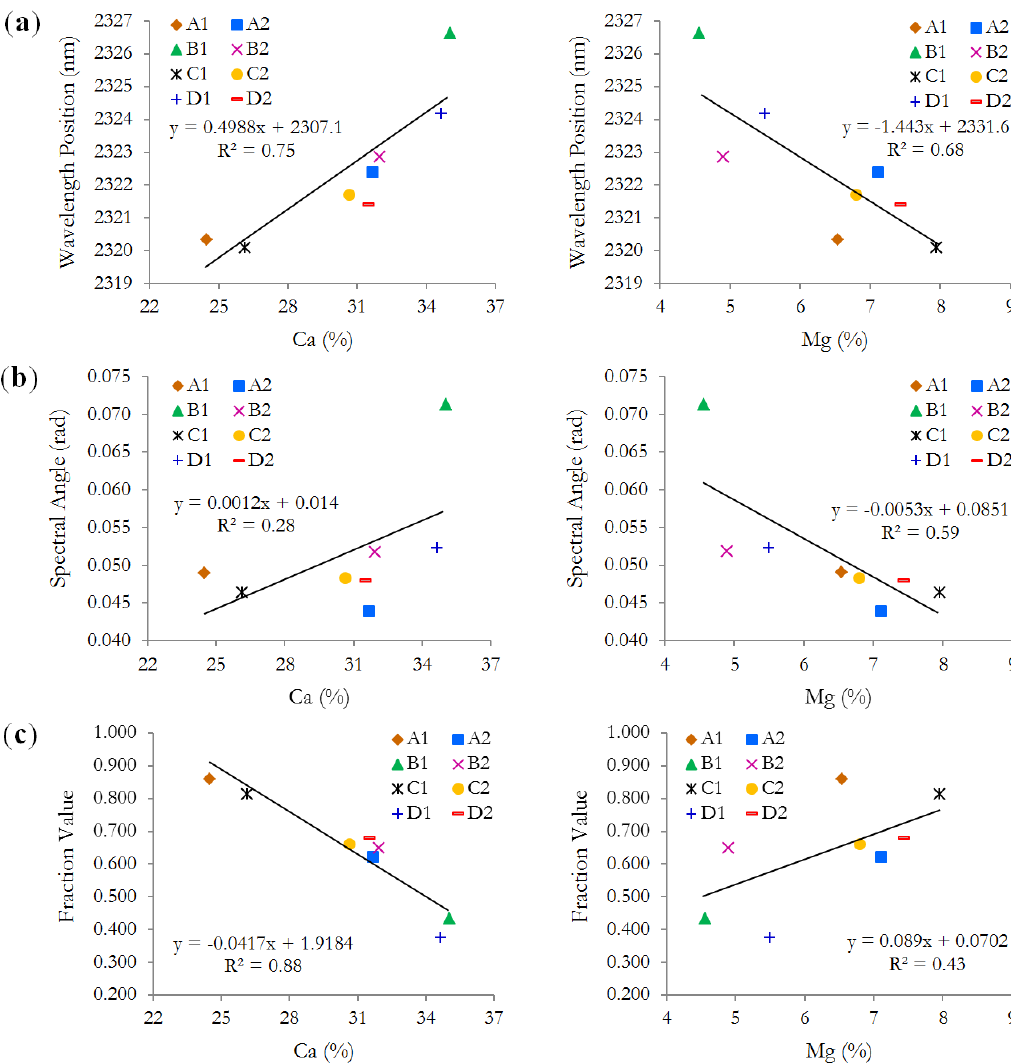
Figure 10. Correlation between major geochemical elements in the carbonate samples and the average of spectral parameter results of the classified images. Physical model relating Ca and Mg contents in the carbonate samples and spectral parameters derived from images classified by ( a ) wavelength position analysis, ( b ) and ( c ) SAM and unconstrained LSU methods for 100D images, respectively. These average spectral classification results were acquired on the same regions of interest (ROIs) of the PXRF spot